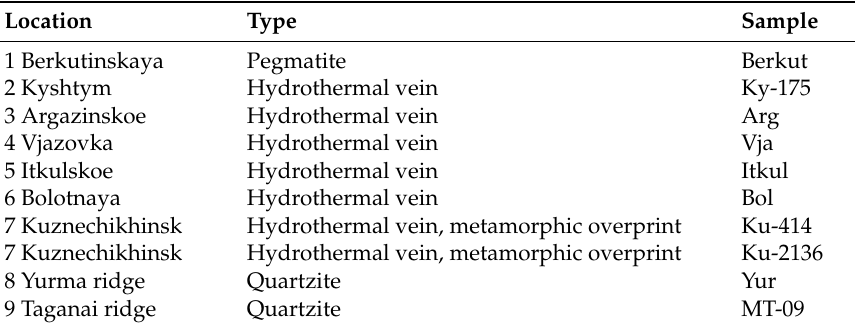
Table 1. Investigated quartz samples from the Southern Ural region (Russia). Location Type Sample 1 Berkutinskaya Pegmatite Berkut 2 Kyshtym Hydrothermal vein Ky-175 3 Argazinskoe Hydrothermal vein Arg 4 Vjazovka Hydrothermal vein Vja 5 Itkulskoe Hydrothermal vein Itkul 6 Bolotnaya Hydrothermal vein Bol 7 Kuznechikhinsk Hydrothermal vein, metamorphic overprint Ku-414 7 Kuznechikhinsk Hydrothermal vein, metamorphic overprint Ku-2136 8 Yurma ridge Quartzite Yur 9 Taganai ridge Quartzite